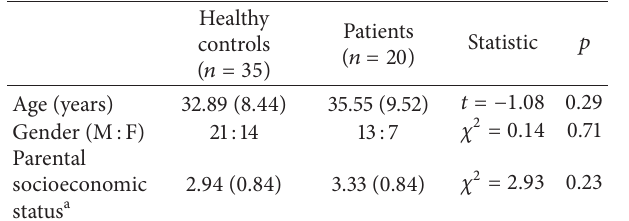
Table 1: Demographic data of CogState research battery normative sample.